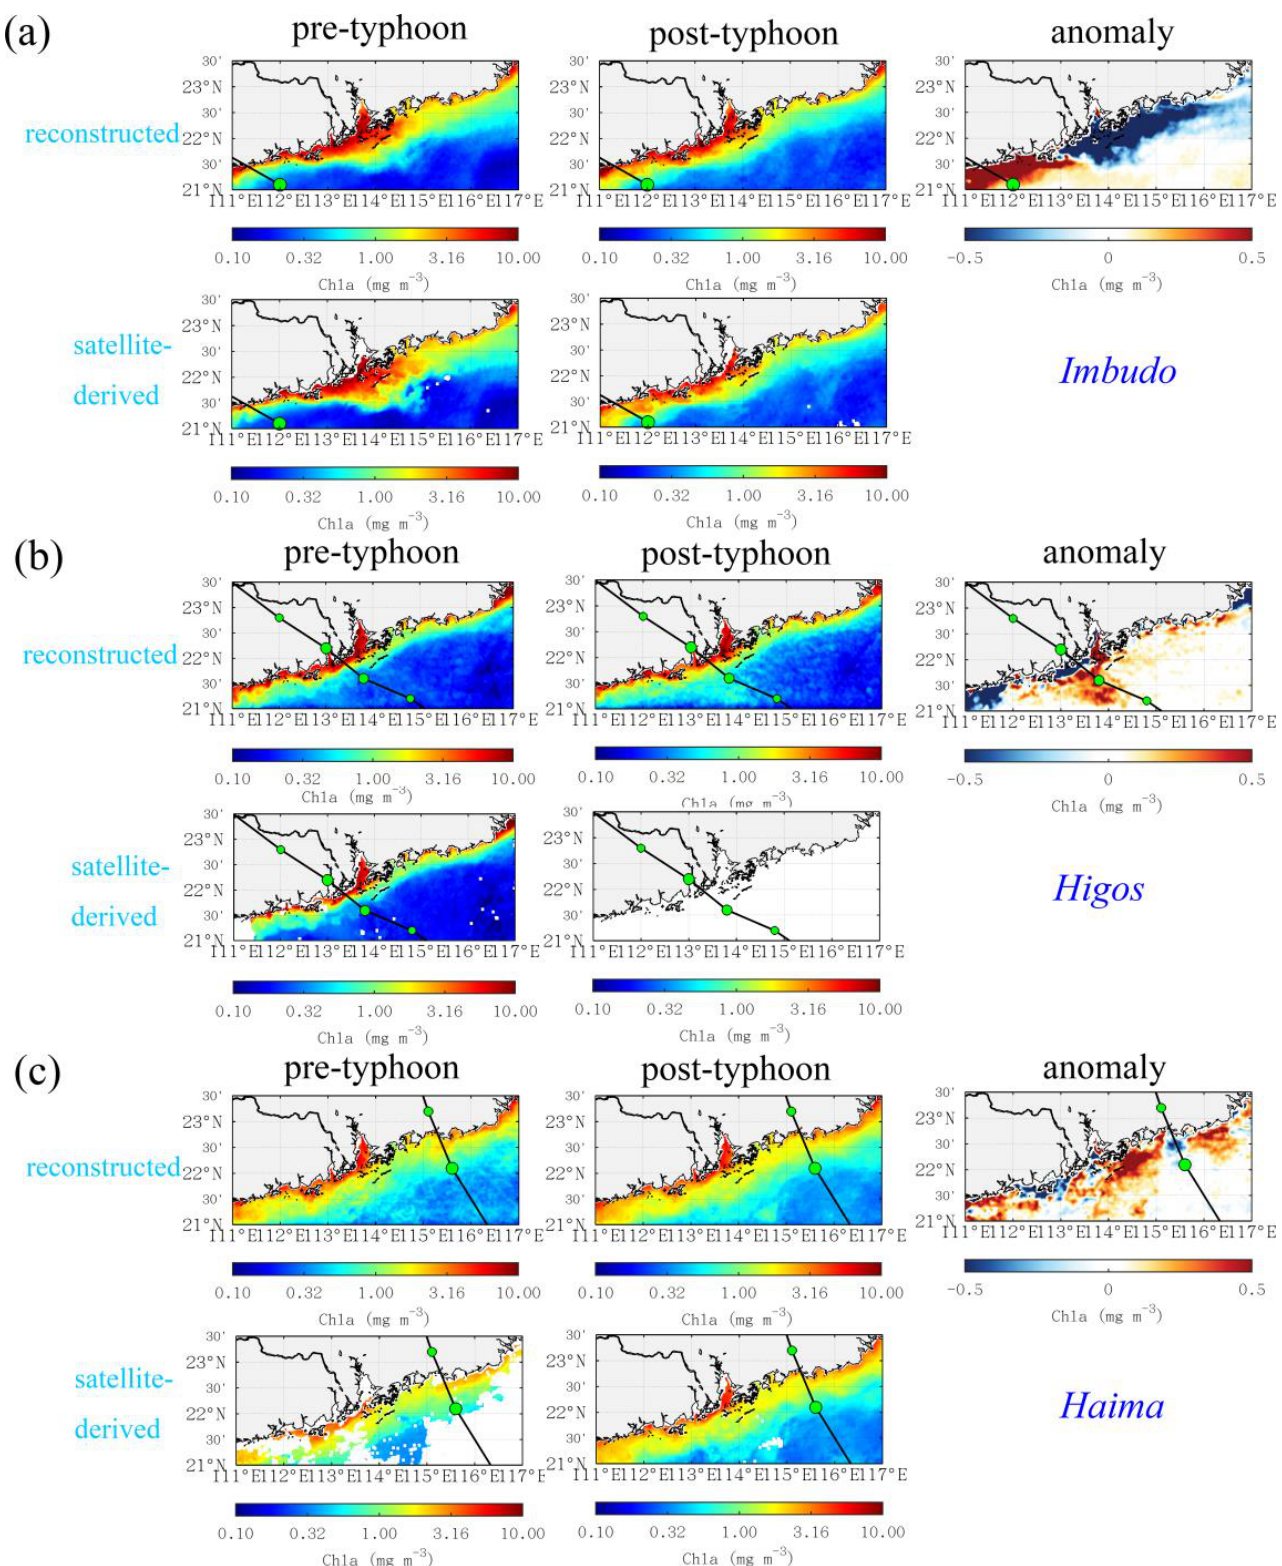
Figure 12. Change of the before and after the three typhoons: ( a ) Imbudo; ( b ) Higos; ( c ) Haima. The surface C chla response varies greatly both in spatial distribution and among indi- vidual events. However, two general and obvious phenomena can still be noticed. One